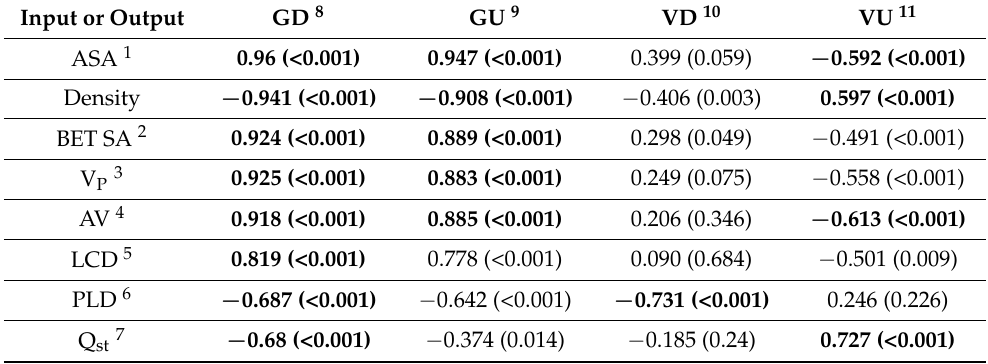
Table 2. Bivariate Pearson’s correlations between the various input and output variables used in this work. The value in the brackets indicates the corresponding two-tailed p -value of the